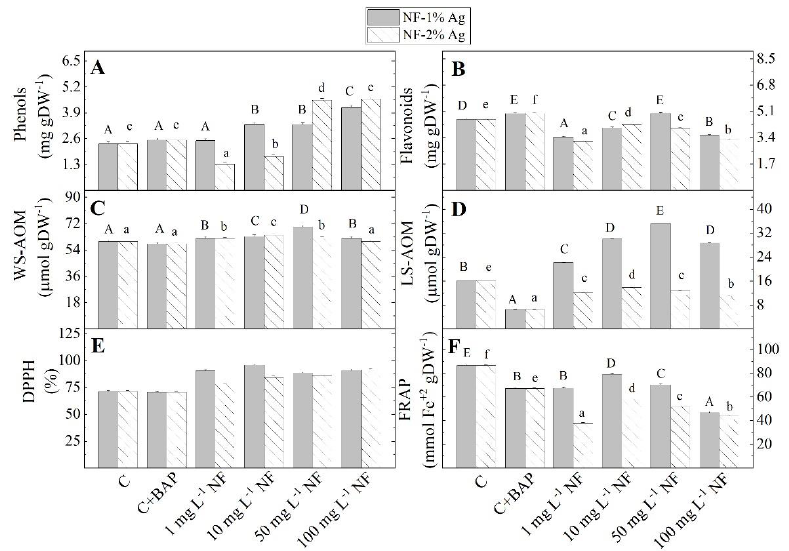
Figure 6. The content of metabolites with antioxidant power (total phenolic compounds (A) and flavonoids (B), WS-AOM (C) and LS-AOM (D)) and antioxidant potential (DPPH (E), FRAP (F)) in S. rebaudiana plantlets in vitro propagated on MS medium, on MS medium with BAP, and on MS medium supplemented with various concentrations (1, 10, 50, 100 mg L − 1 ) of aminoacid nanofibers enriched with 1% and 2% colloidal Ag (NF-1%Ag, NF-2%Ag). Values are means ± SE, n = 20; differ- ent letters indicate significant differences assessed by the Fisher LSD test ( p ≤ 0.05) after performing ANOVA one- way analysis. We used the letter ‘a’ or “A” for the lowest data value and ascending to the next letters for higher-data values. The statistical analysis of NF-1%Ag (uppercase) and NF- 2%Ag (lowercase) was performed separately. The addition of 50 mg L −1 NF-1%Ag to the MS medium caused the highest total fla- vonoid content, water- and lipid-soluble metabolites with antioxidant capacity in stevia plantlets. The highest content of total phenols (4.170 mg g DW −1 ) was obtained in plantlets grown on a nutrient medium supplemented with 100 mg L −1 of NF-1%Ag. The supple- mentation of the MS medium with 1, 10, 50, or 100 mg L −1 NF-2%Ag also led to a decrease in the FRAP, total flavonoids, and LS-AOM compared to control plants. The highest level of total flavonoid content, WS-AOM, LS-AOM content, and the highest FRAP activity were assayed when 10 mg L −1 NF-2%Ag was added to the MS medium, compared with other investigated concentrations. However, with increasing the concentration of NF- 2%Ag from 50 to 100 mg L −1 the level of these parameters decreased. Only DPPH scaveng- ing activity and TPC were highest at 100 mg L −1 NF-2%Ag. It was found that stress markers such as proline, malondialdehyde (MDA), and H 2 O 2 decreased when plants were micropropagated in an MS medium supplemented with BAP (Figure 7). In general, the addition of NF-1%Ag to the MS medium at all studied concen- trations caused an additional decrease in MDA and H 2 O 2 content compared with the con- trol untreated plants. The addition of all tested concentrations of NF-2% Ag showed dif- ferent effects on oxidative stress than the addition of NF-1%Ag. At 100 mg L −1 NF-2%Ag, the content of stress markers drastically increased, and the content of SH- groups de- creased compared with other tested concentrations. An increase in proline content in the presence of NF-Ag, with the only exception at 50 mg L −1 NF-2%Ag, compared to control was observed, and this increase was more significant under NF-1%Ag. The maximum values of this stress marker were enriched at higher NF-1%Ag concentrations (50 and 100